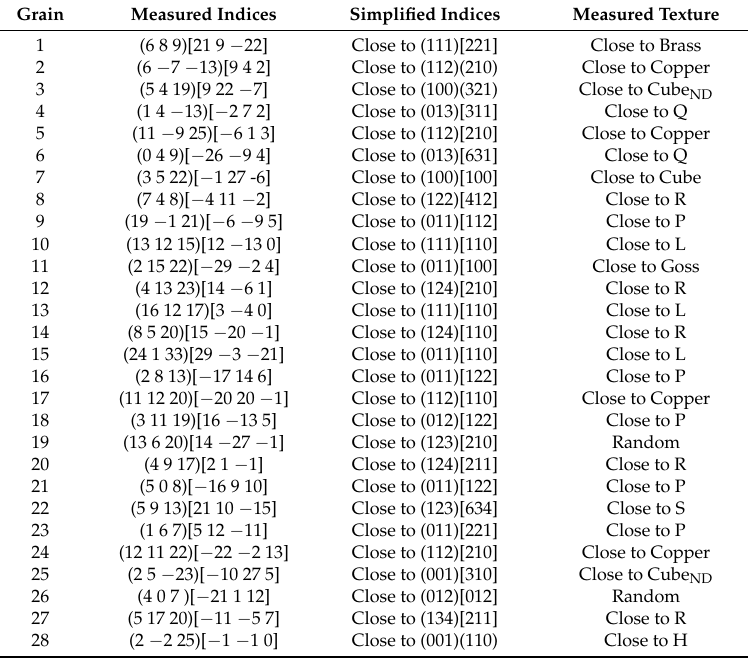
Table 3. The orientations of grains near fatigue crack in sample A.